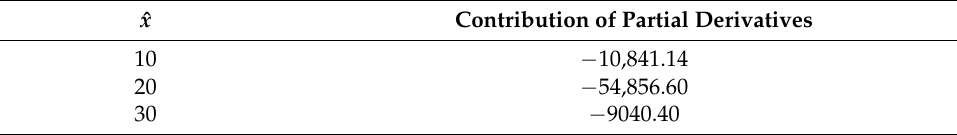
Table 1. The value of the first two terms of Equation (29) for the following set of the parameter